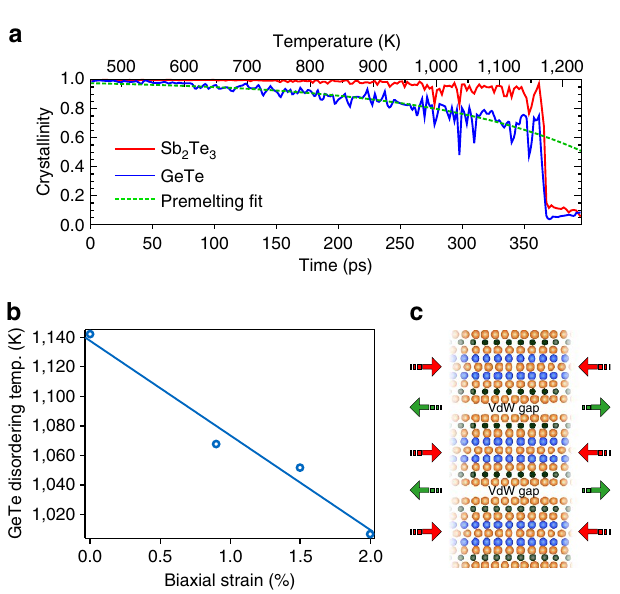
Figure 2 | Strain-controlled interfacial premelting. ( a ) The crystallinity evolution for the 2% biaxially strained Sb 2 Te 3 –GeTe vdW superlattice. The crystallinity of the Sb 2 Te 3 layers (red) remains close to 1.0 until the superlattice structure melts. In contrast, the GeTe layers (blue) premelts at B 160K below the melting point of the Sb 2 Te 3 layer. The dashed green line is a fit to the GeTe crystallinity and was used to determine the temperature that the crystallinity dropped to 0.8, which we defined as the disordering temperature. Similar plots for 0% strain, 0.9 and 1.5% biaxial strain are given in Supplementary Fig. 3. ( b ) The disordering temperature of the GeTe layers is plot as a function of biaxial strain in the GeTe layers. Increasing the biaxial strain decreases the GeTe disordering temperature. ( c ) Relaxed Sb 2 Te 3 –GeTe vdW heterostructure. The direction of strain in the 2D crystal lattices alternates between tensile (GeTe) and compressive (Sb 2 Te 3 ) relative to their respective bulk crystal lattices. The red and green arrows indicate the layers subjected to compressive and tensile strain respectively. The atomic colours are: Ge atoms—black, Sb atoms—blue, and Te